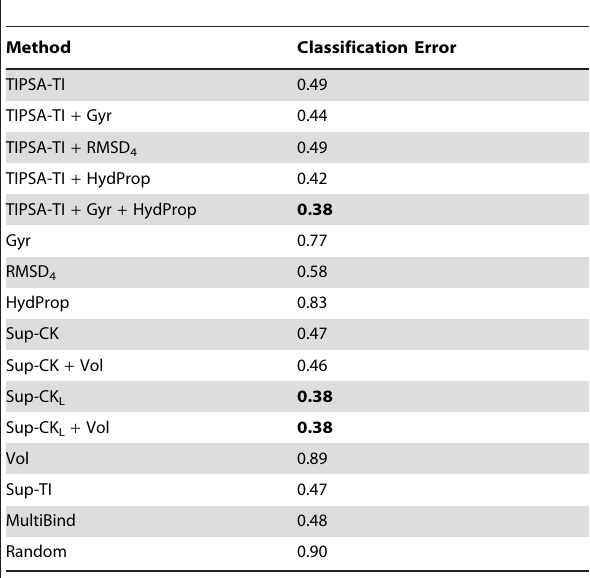
Table 5. Results of k -nearest neighbor classification for the Homogeneous (5.3 A˚) data set.